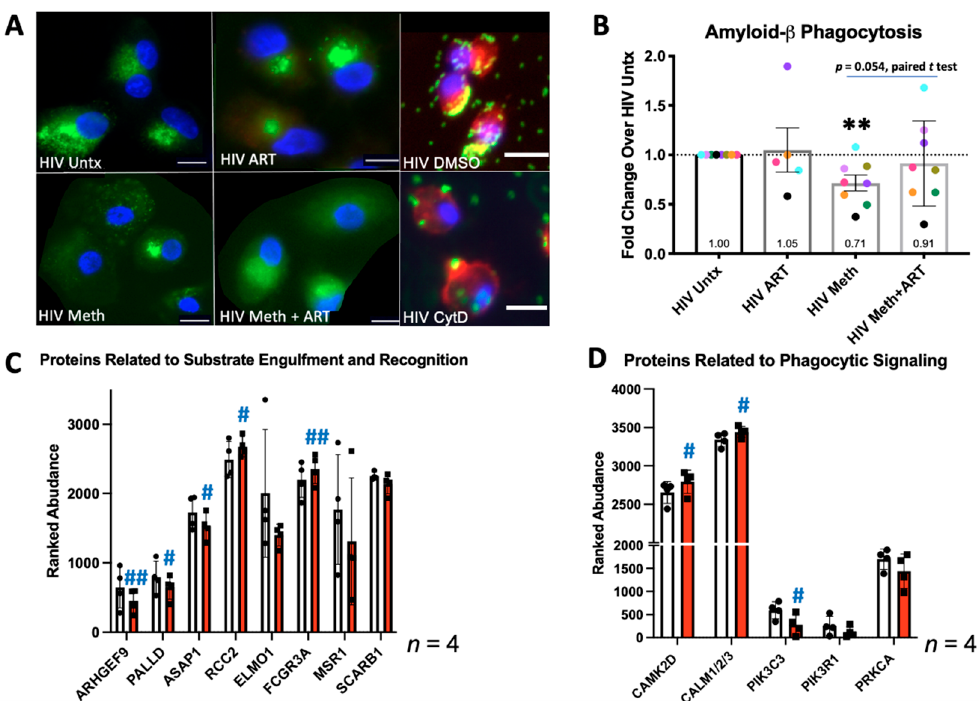
Figure 2. Phagocytosis of 1–42 amyloid- β by HIV-infected MDM. Macrophages were infected with HIV for 3–4 days, treated with methamphetamine (meth, 50 µM) and/or ART (16 nM of tenofovir, 441 nM of emtricitabine and 43 nM of dolutegravir) for 24 h, and in the last two hours, fluorescent 1–42 β -amyloid (green) was added prior to fixation, mounting, and visualization. Control cells were pre-incubated with 20 µM of cytochalasin D (CytD) for 20 min and was present throughout phagocytosis. ( A ) Representative images of untreated (HIV Untx), HIV ART, HIV, Meth, and HIV Meth + ART with HIV DMSO and HIV CytD as controls. HIV DMSO and HIV CytD cells were counterstained with Alexa 594 conjugated phalloidin (red). ( B ) Fold change in median accumulation of amyloid- β per cell during phagocytosis, with HIV Untx set to 1.0 in each experiment. ( C , D ) Differentially expressed proteins detected by mass spectrometry related to phagocytic substrate recognition, engulfment, and signaling, HIV Untx is in white bars and HIV Meth is in red bars. n = 4–8 with 50–75 cells counted per treatment in each microscopy experiment ** p < 0.01 one-sample t test, # p < 0.05 ## p < 0.01 paired t test. Scale bar is 15 µm. Error bars represent SEM for ( B ) and SD for ( C , D ).